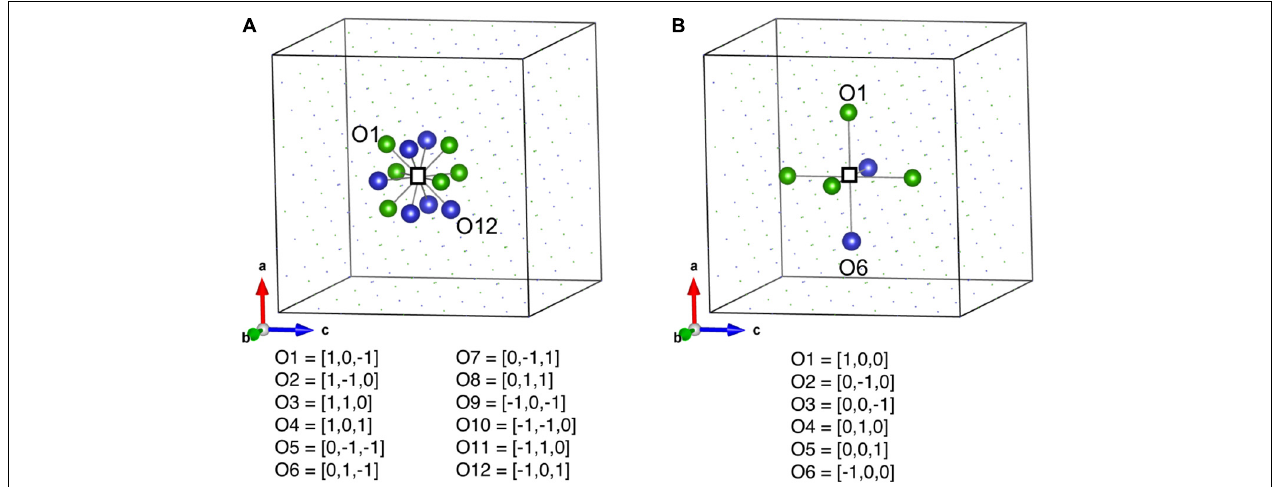
FIGURE 2 | (A) Schematic representation of 1NN and (B) 2NN nearest neighbor atoms of a vacancy. Empty square is the vacancy. The 1NN and 2NN atoms are categorized into different vectors based on their orientation with respect to the vacancy.